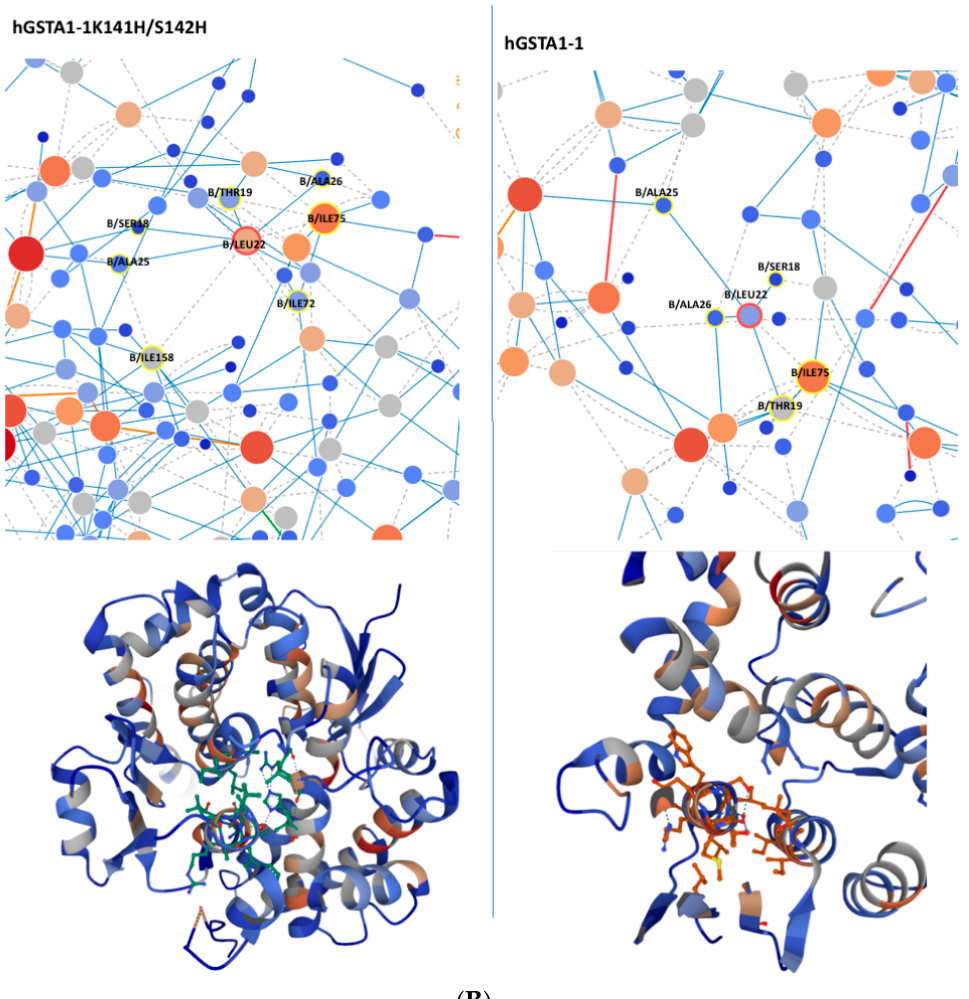
Figure 10. ( A ) Network around Phe136 of hGSTA1-K141H/S142H and hGSTA1-1; ( B ) network around Leu22 of hGSTA1-1. The picture was created with the program RING [37]. Blue, grey, green, and red lines represent H-bond, van de Waals, π -cation, and π - π stack interactions, respectively.